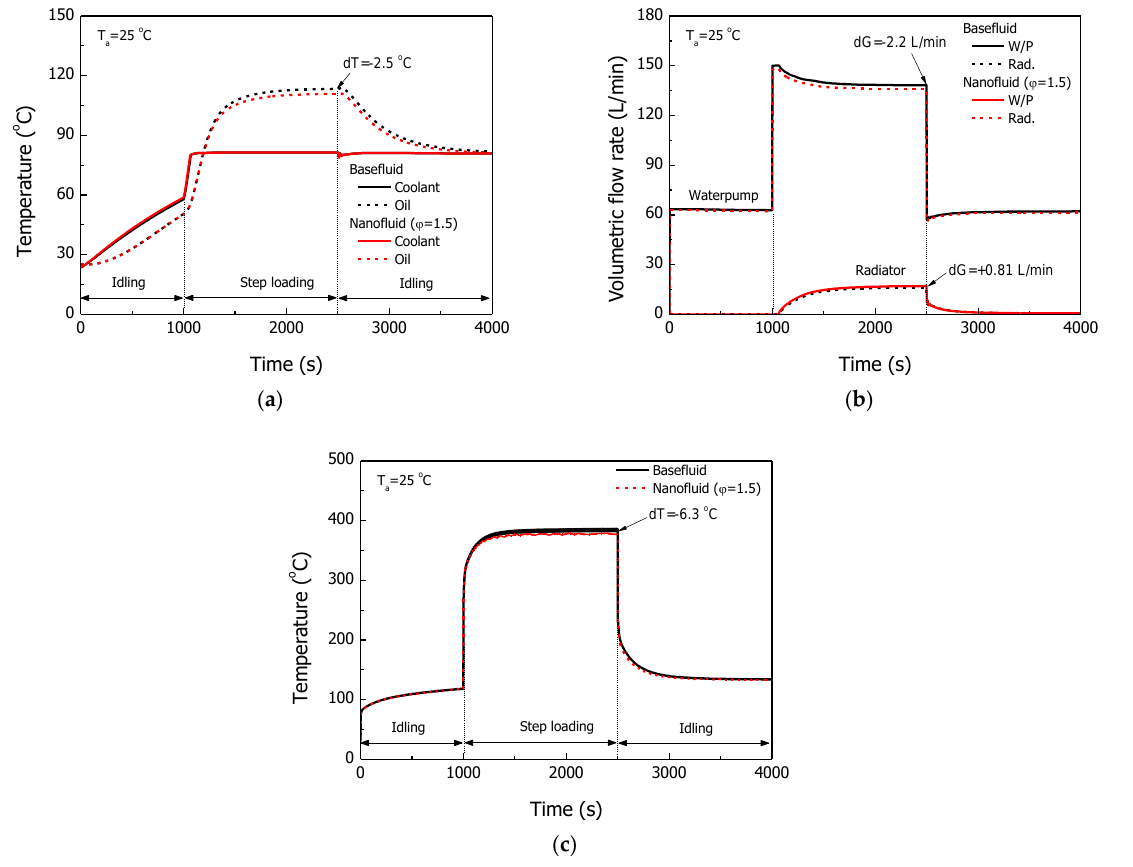
Figure 10. Thermal performance results of the diesel engine with Al 2 O 3 nanofluids at 216 Nm step-load and 2050 rpm engine speed: ( a ) coolant and oil temperatures; ( b ) water pump and radiator flow rates; ( c ) exhaust gas temperatures.